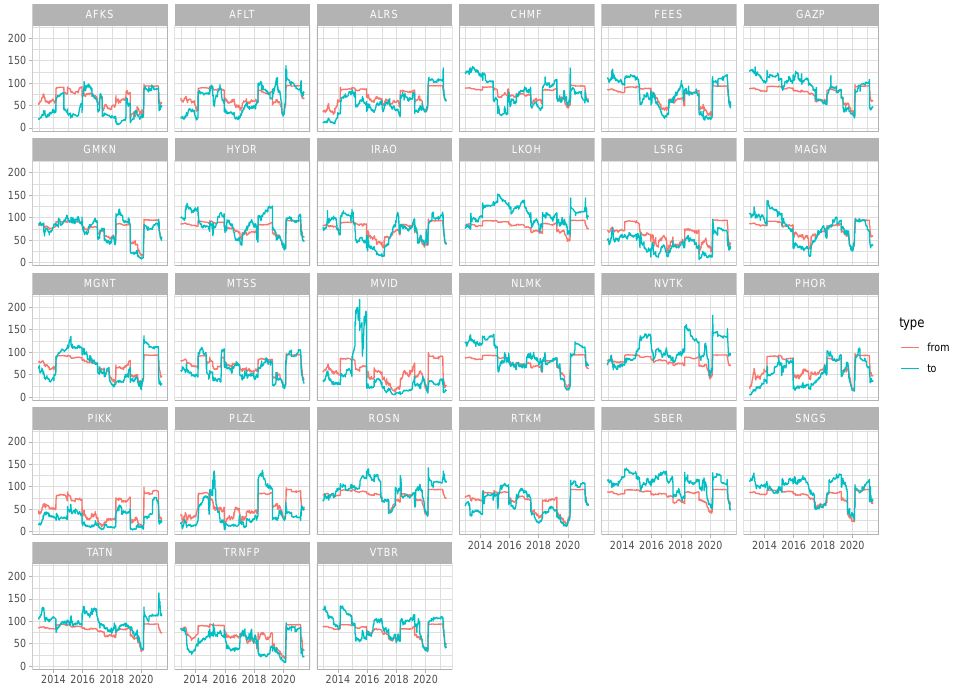
Figure 10. Overall Directional